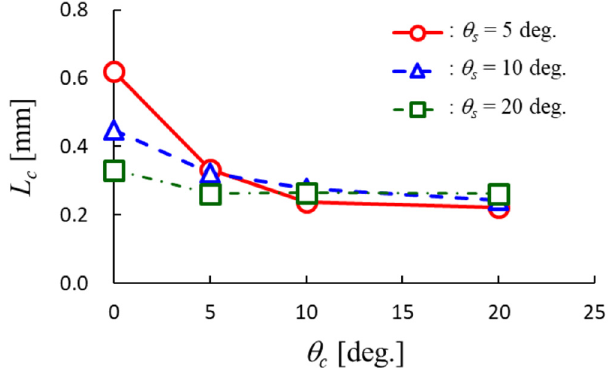
Fig. 10. In fl uence of u s and u c on L c .